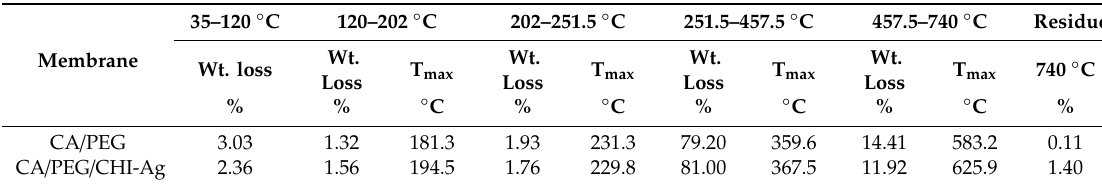
Table 4. The weight loss (Wt. loss) and maximum decomposition temperature (T max ) of CA / PEG and CA / PEG / CHI-Ag